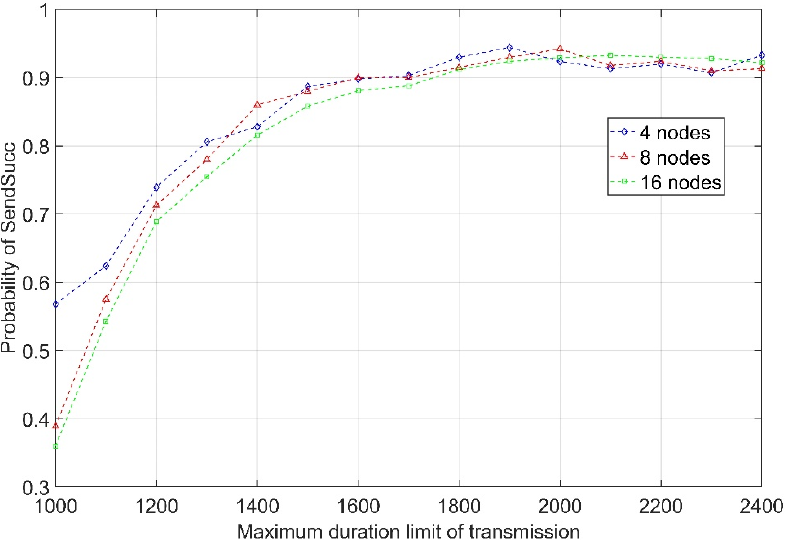
Figure 12. Transmission accuracy for various values of t_Done_Time in various numbers of nodes. Taking four slave nodes attached to the CAN bus, the upper limit of the successful transmission probability under the FMA-RNN within the timing constraints is 97.4%, which is a decrease of 1.8% when compared to the previous normal rate. Meanwhile, as shown in Table 6, the node’s successful response rate decreased by 4.3% on average when the FMA-RNN was added. Table 6. The transmission accuracy and the successful response rate in the three cases. Normal